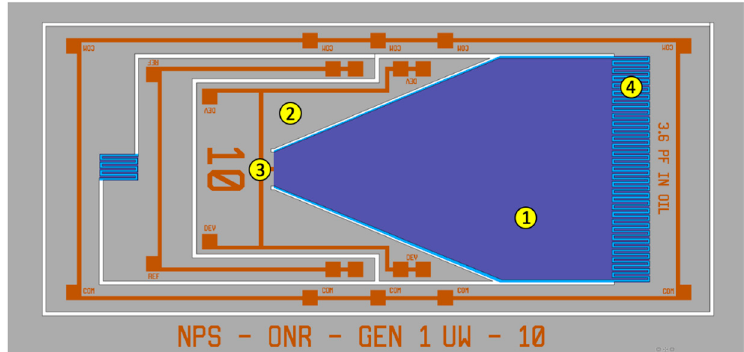
Figure 1. Layout diagram of the acoustic directional microelectromechanical systems (MEMS) sensor, designed for underwater operation, showing a free-standing single wing (1) connected to the substrate (2) through a pivot point (3), and the interdigitated comb finger capacitors (4) at the edge of the wing.